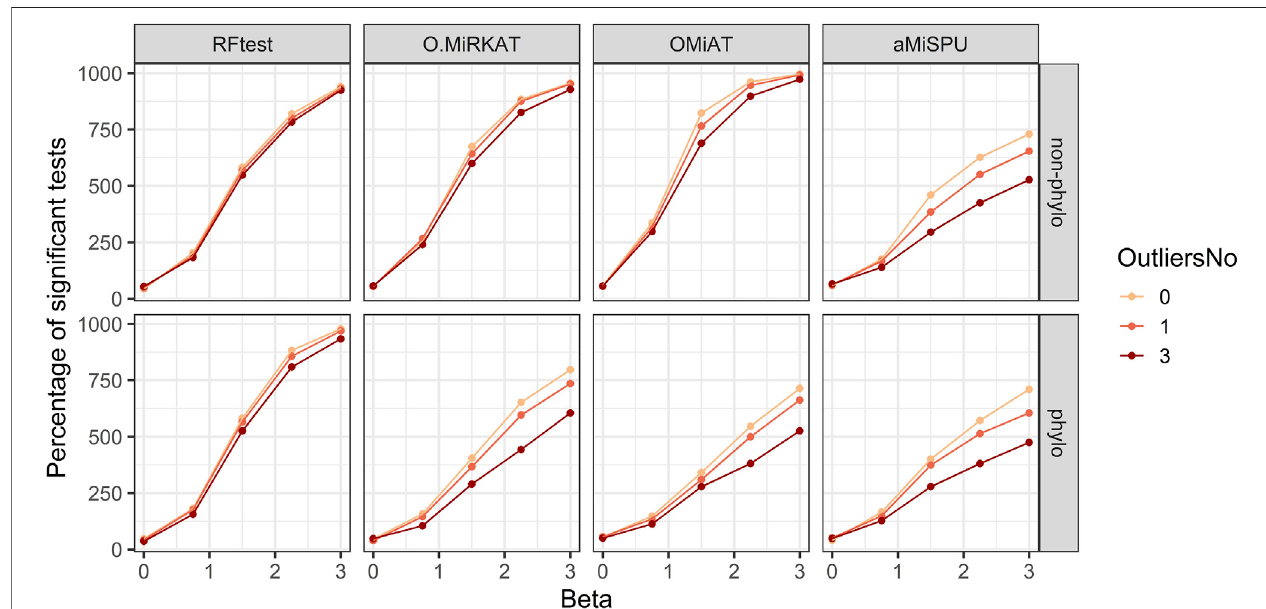
FIGURE 5 | Power curves of the competing methods when outliers were present. The outcome variable was binary, and two signal types, phylogenetic and non- phylogenetic, with a density of 15% were assessed. Zero to three outlier samples were included.